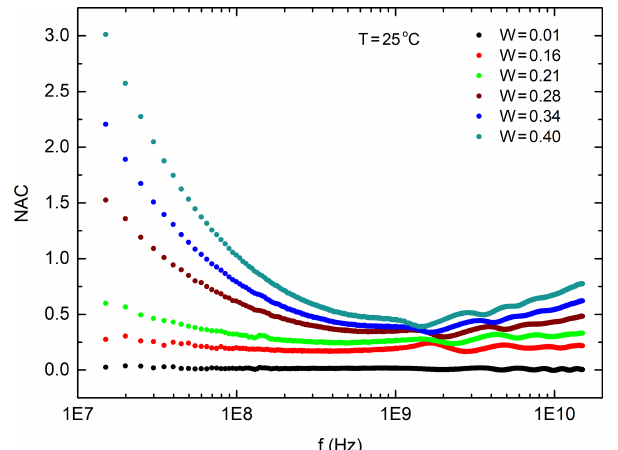
Figure 3. The spectra of the normalised attenuation coefficient (NAC) for sample no. 6 (TM) depending on the volumetric mois- ture content of the soil sample ( W ) at a temperature of T = 25 ◦ C.